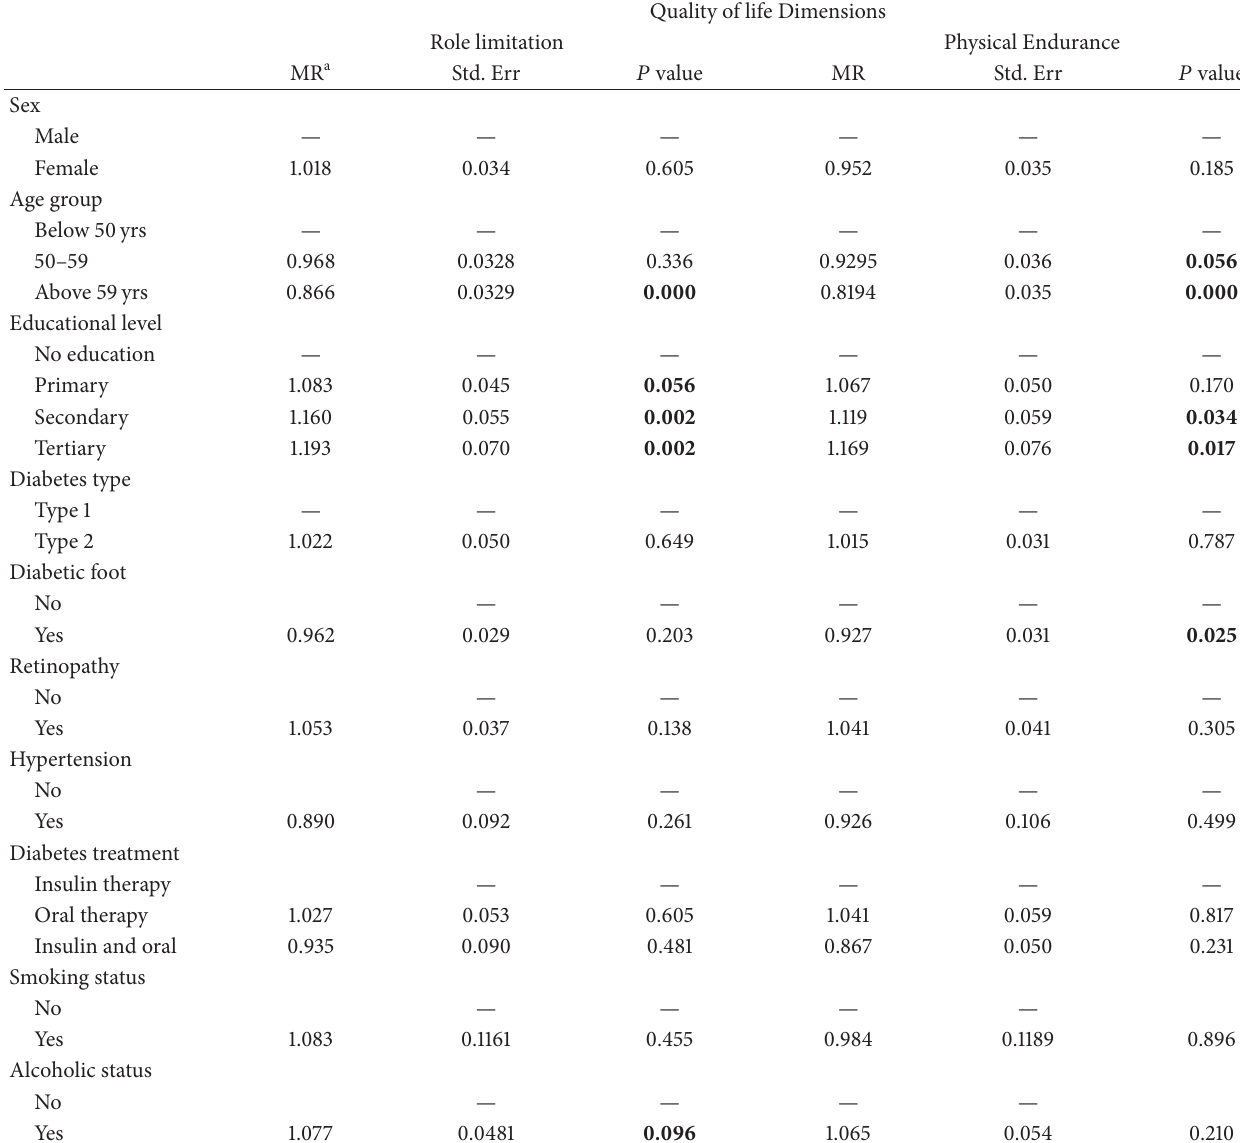
Table 6: Regression estimates of quality of life in a multivariable analysis.